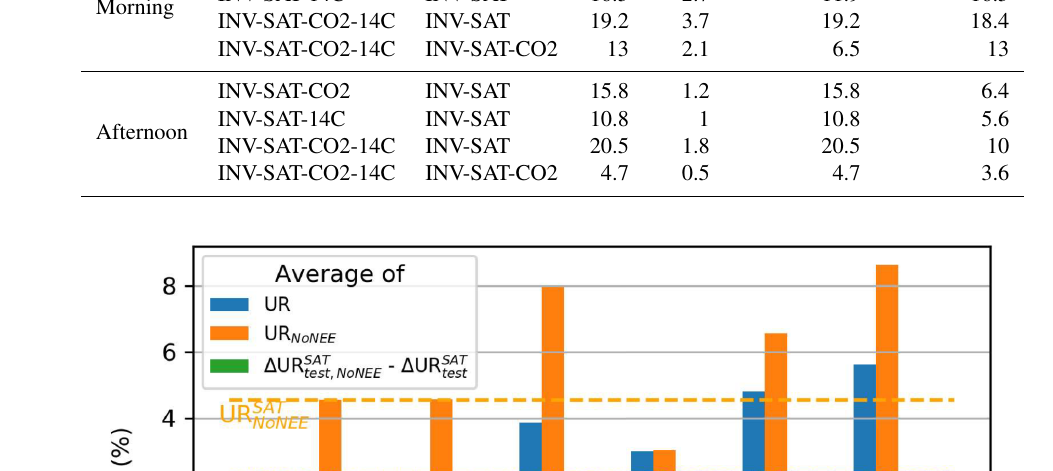
Table 8. CO 2 and/or 14 CO 2 ground network impact in addition to satellite observation: (cid:49) UR Ref budgets, maximal value on the AOI (column Max), and value of the two most impacted areas (Île-de-France and North Rhine-Westphalia columns).